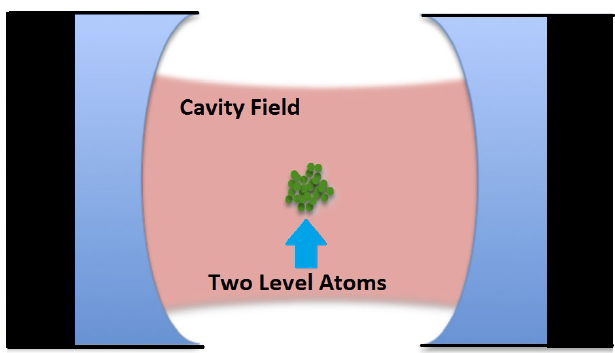
Figure 1. Sketch of the system considered in this paper: Collection of N identical atoms confined in a small volume at the center of the optical cavity coupled to the quantum field of the cavity by their electric